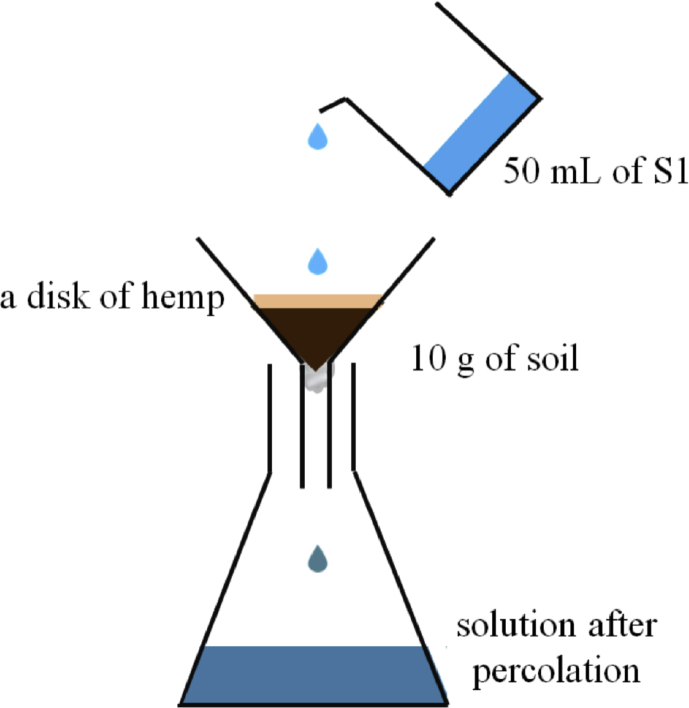
Percolation procedure: this is an extraction process that involves the slow descent of solution S1 through the soil, in absence or presence of a hemp disk; the number of passes through the system was 1, 5, 10 or 15.